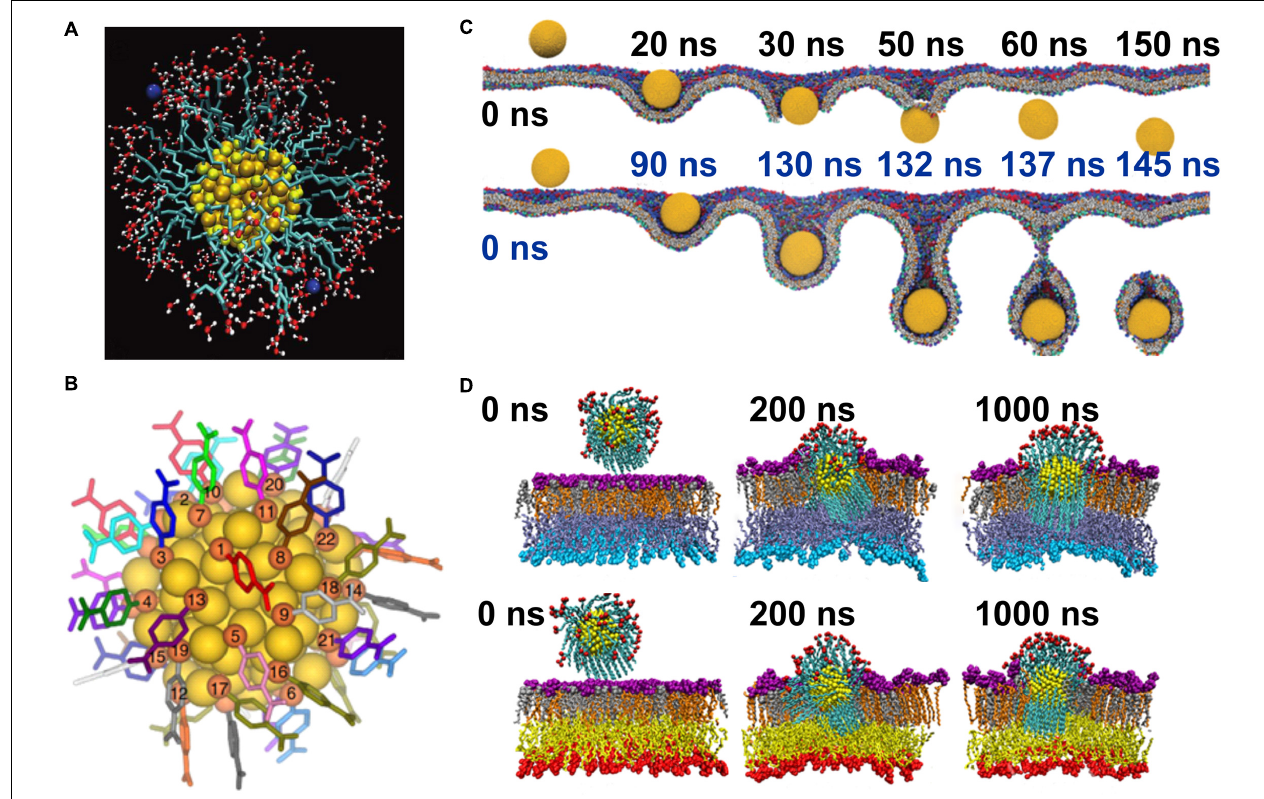
FIGURE 7 | Gold nanoparticles. (A) Gold nanoparticle coated with dodecanoic acid, hydrating water and ions are shown, reproduced with permission from Heikkilä et al. (2012), Copyright (2012) American Chemical Society; (B) gold nanoparticle coated with para-mercaptobenzoic acid, gold is shown in yellow and sulfur in orange, reproduced from Salorinne et al. (2016), Copyright: 2016; (C) snapshots of (upper panel) internalizations of a neutral gold nanoparticle and (lower panel) uptake of a positively charged gold nanoparticle, reproduced with permission from Lunnoo et al. (2019), Copyright (2019) American Chemical Society; (D) snapshots of the MD trajectory of the insertion of amphipathic janus nanoparticle into lipid bilayers, reproduced with permission from Ou et al. (2020), Copyright (2020) American Chemical